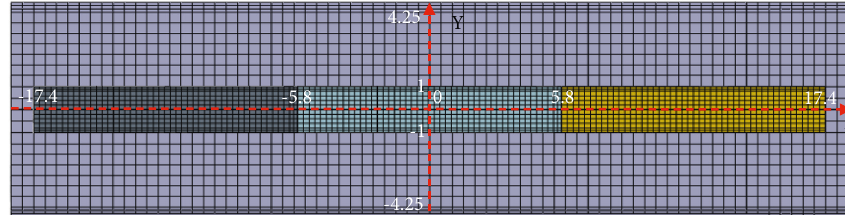
Figure 8: Top view coordinate map of bed